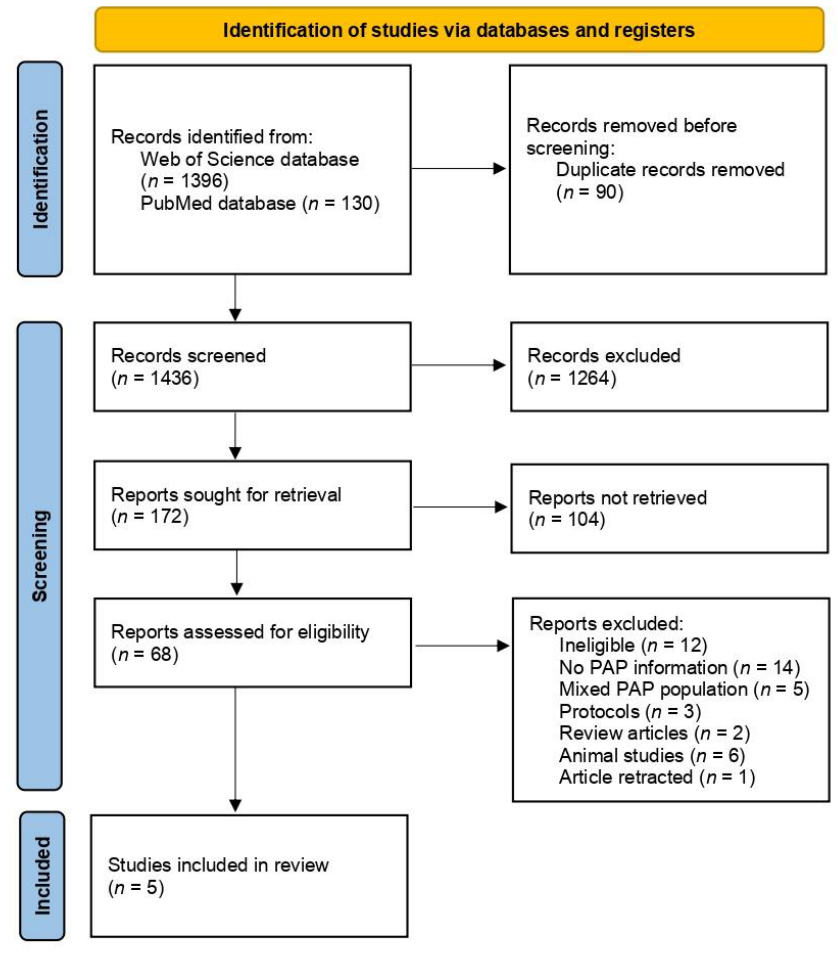
Figure 1. Procedure of identification, screening, and inclusion of randomized controlled trials applied within this study.